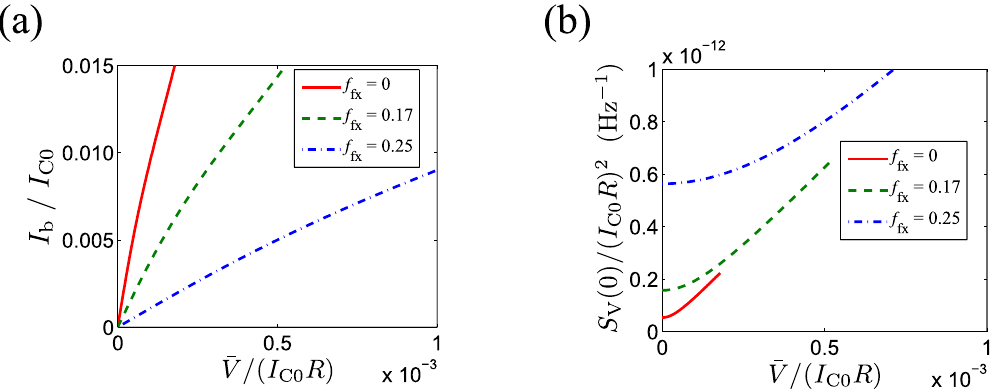
Figure 2. Numeric calculations based on the P ( E ) theory. ( a ) Mean voltage V as a function of bias current I b / I C0 , with I C0 the zero-flux critical current of JJ. ( b ) Zero-frequency spectrum of voltage noise S V (0) as a function of mean voltage V . The curves in both plots are shown for three filling factors: f fx = 0, 0.17 and 0.25. The mean voltage V in ( a ) is calculated using equations (3–6) and the noise S V (0) is calculated using Eq. (7). In the calculation, Z ( ω ) = R + j ω L is used, where R = 60 Ω and L = 0.8 μ